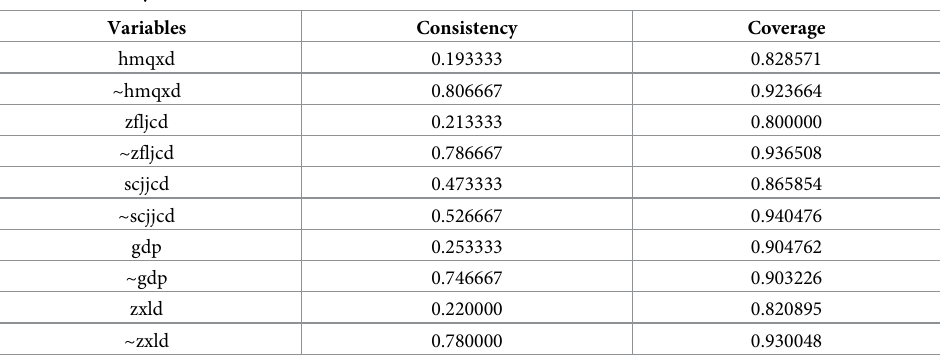
Table 6. Necessity test form.